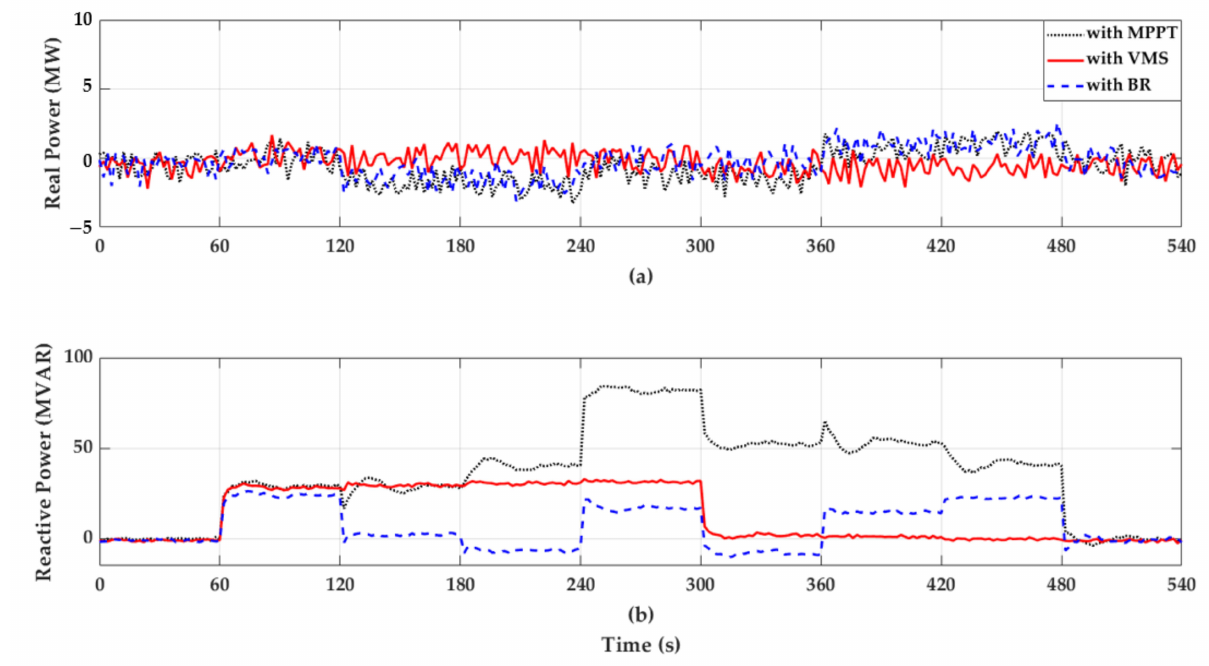
Figure 6. Total real ( a ) and reactive ( b ) power loss changes of the power system according to the CBG’s control